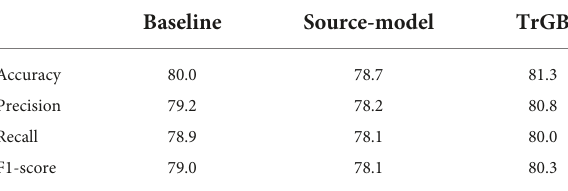
FIGURE2 F1-score using the three methods, baselines, source-model, and TrGB for the three classification tasks, CN/MCI/AD, CN/MCI, and CN/AD, using multimodal data. TABLE 8 Early MCI vs. late MCI classification scores for the baselines and TrGB scenarios using the multimodal